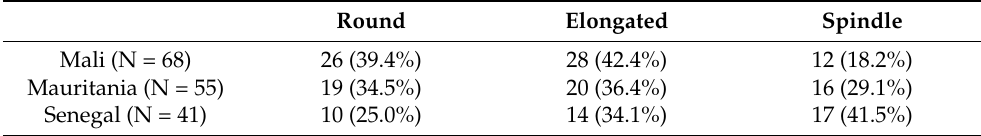
Table 6. Number and percentage (%) of S. haematobium eggs detected in each morphotype (round, elongated and spindle) from Mali, Mauritania and Senegal. Round Elongated